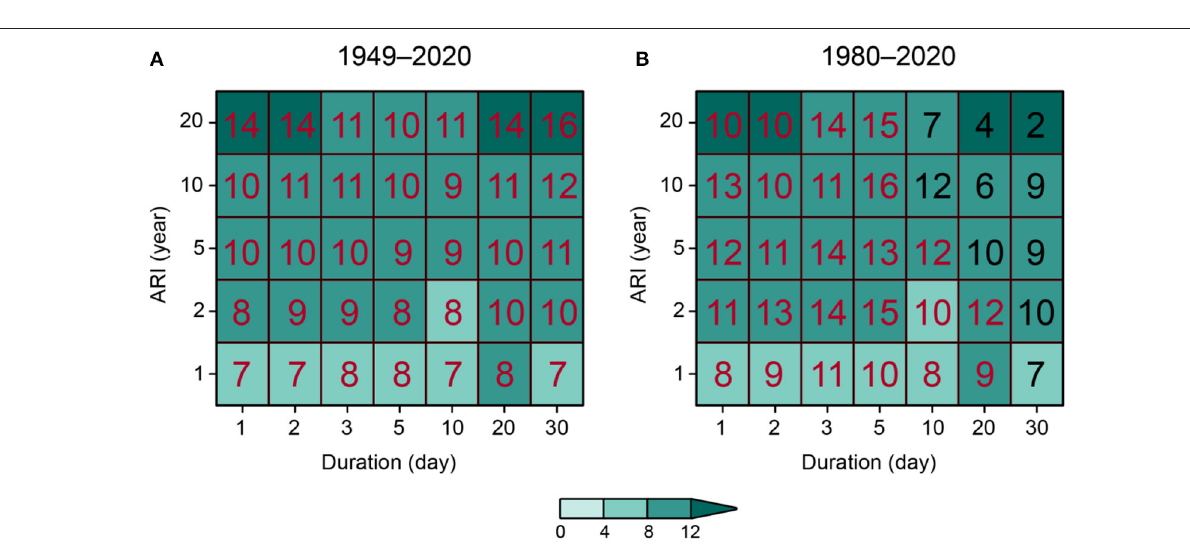
FIGURE 8 | Trends (% decade − 1 ) in the frequency of occurrences for the Great Lakes basin of the 35 duration–ARI combinations for the periods of (A) 1949–2020 and (B) 1980–2020. Statistically significant trends are shown in red. All trends are upward. For the 1949–2020 analysis period, all trends are statistically significant ( p = 0.05 significance level for a two-tailed test). For the 1980–2020 period, all trends are statistically significant for the 1, 2, 3, and 5 day durations, but not for the 10, 20, and 30 day